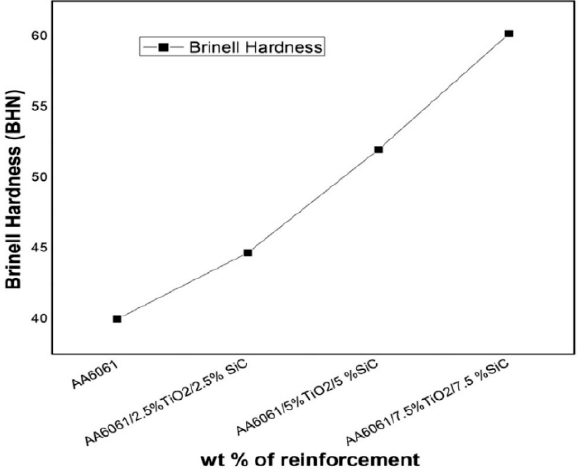
Figure 16. The hardness of AA601 with TiO 2 and SiC as a reinforcement [79].